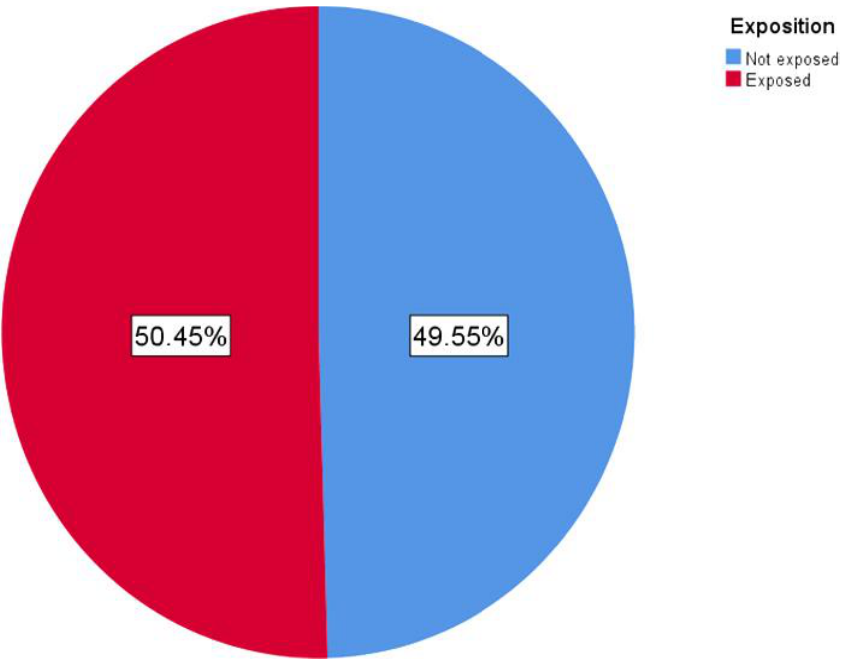
Figure 4. This graph represents distribution of exposed vs. non exposed patients to someone diagnosed with COVID-19 during the last 18 months.